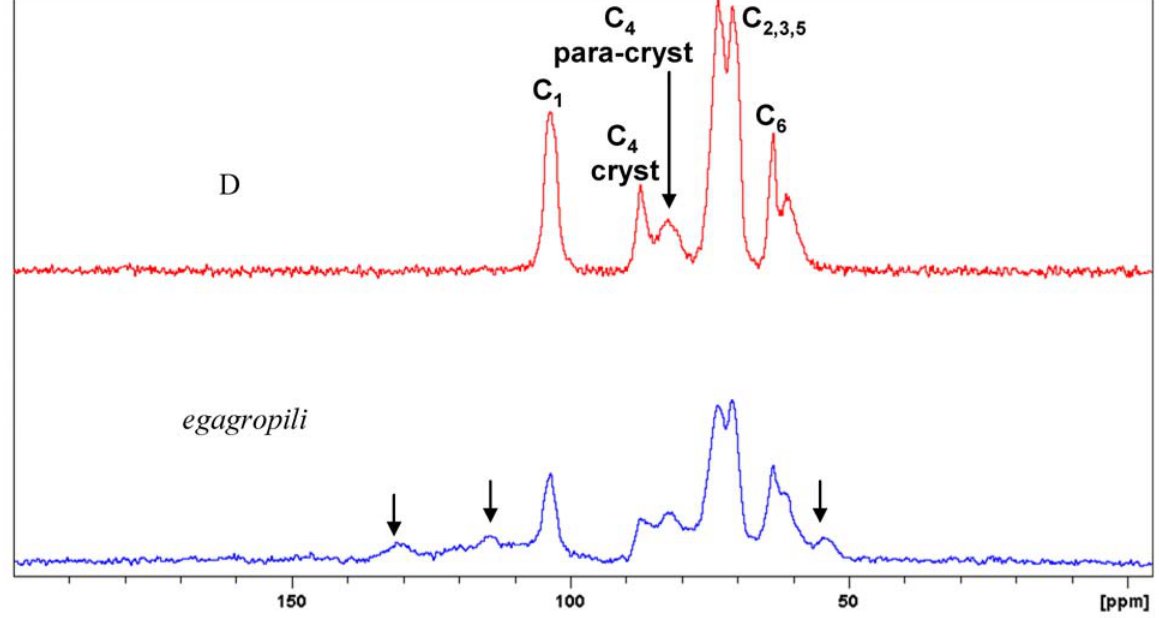
Figure 2. Comparison between the 13 C CP-MAS NMR spectra of P. oceanica (blue) egagropili and cellulose extracted from P. oceanica (red) sample D with the corresponding signal attributions. The arrows in the blue spectrum indicate signals that belong to